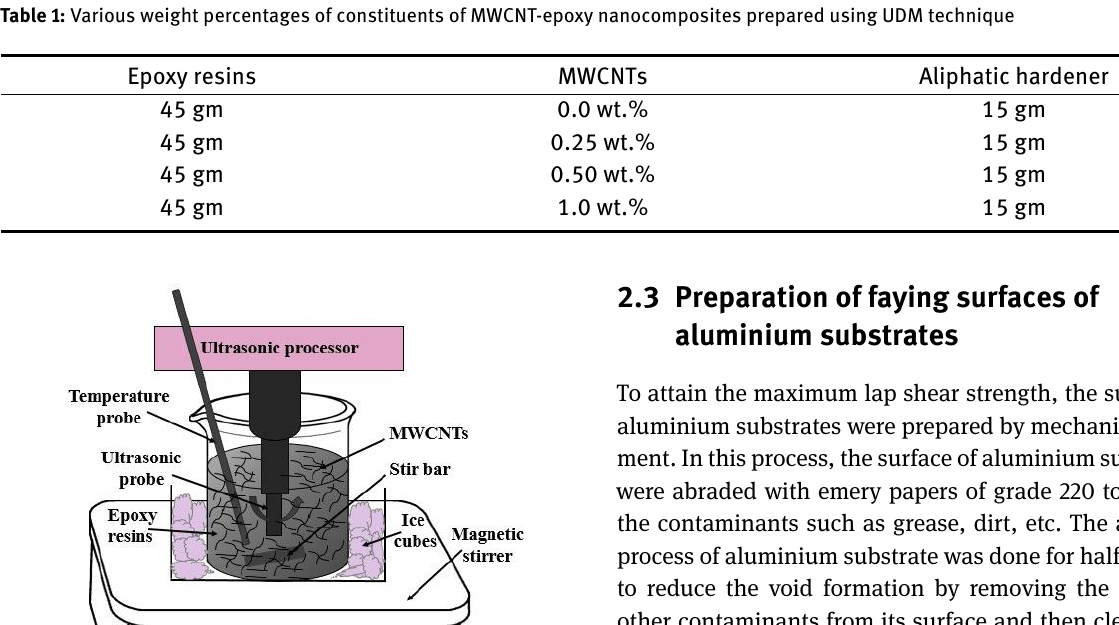
Table 1: Various weight percentages of constituents of MWCNT-epoxy nanocomposites prepared using UDM technique